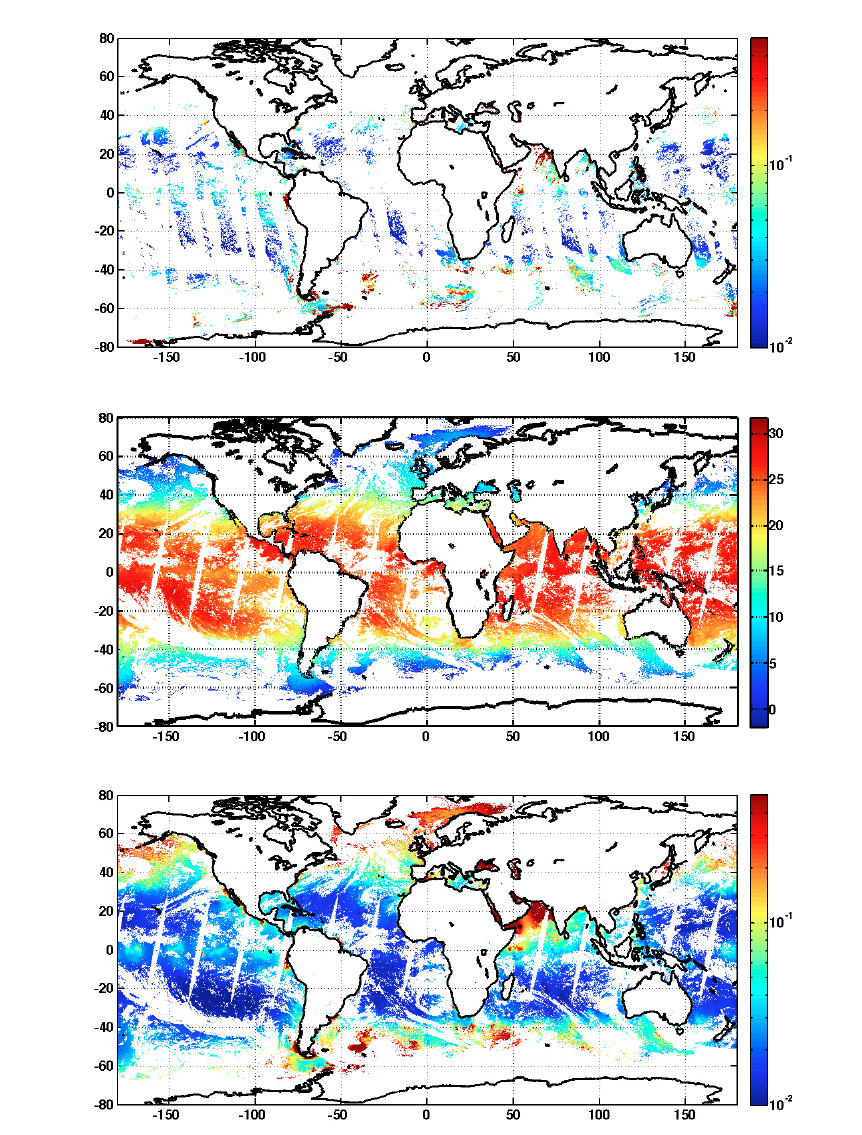
Figure 1. ( top panel ) MODIS Aqua Level 3 Chl- a (mg/m 3 ), ( middle panel ) MODIS Aqua Level 3 SST ( ◦ C) and ( bottom panel ) Level 4 Chl- a concentration (mg/m 3 ) extended to the areas where MODIS SST was available, for 1 January